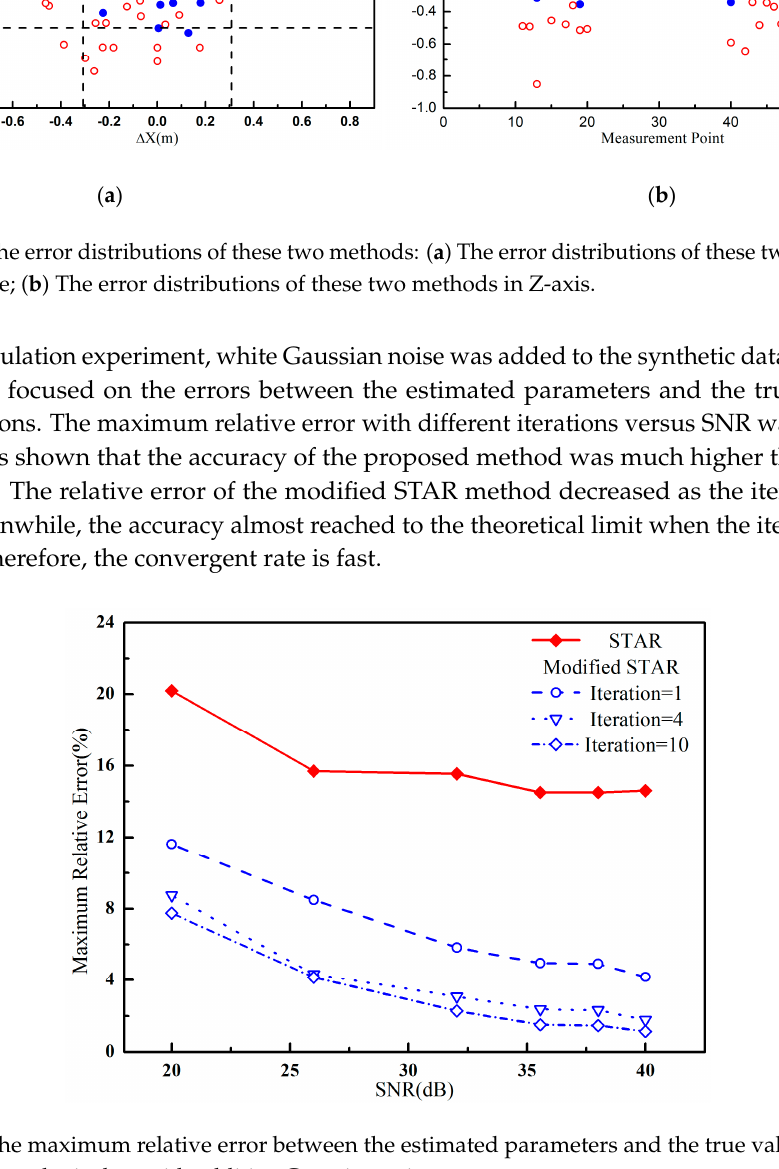
Table 1 . The Specification of the Magnetometer and Data Acquisition. Hardware